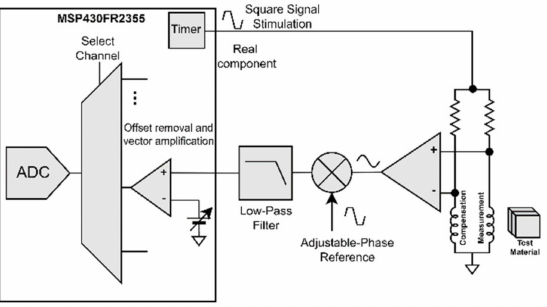
Figure 6. Detailed signal processing hardware architecture.